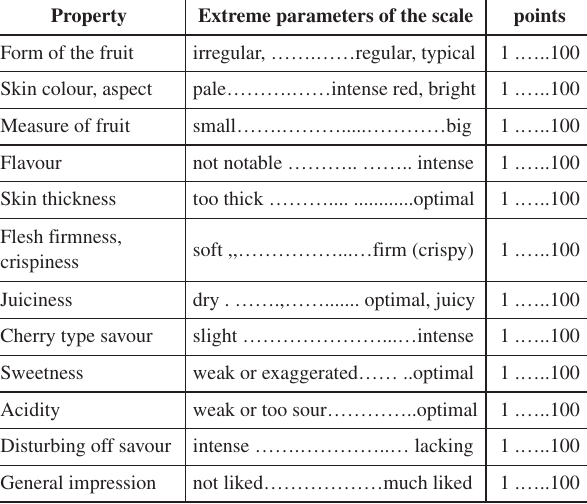
Table 4. Criteria in deciding fruit quality of the sweet cherry samples Property Extreme parameters of the scale points irregular, …….……regular, typical 1 .…..100